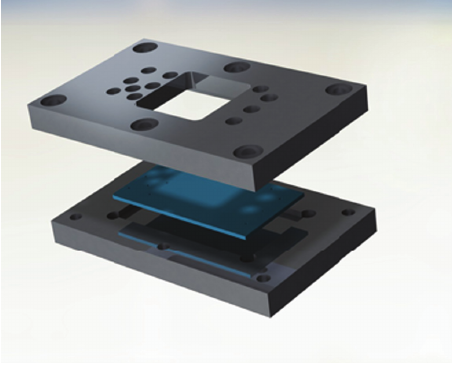
Figure 8 Device constructed to connect the LTCC